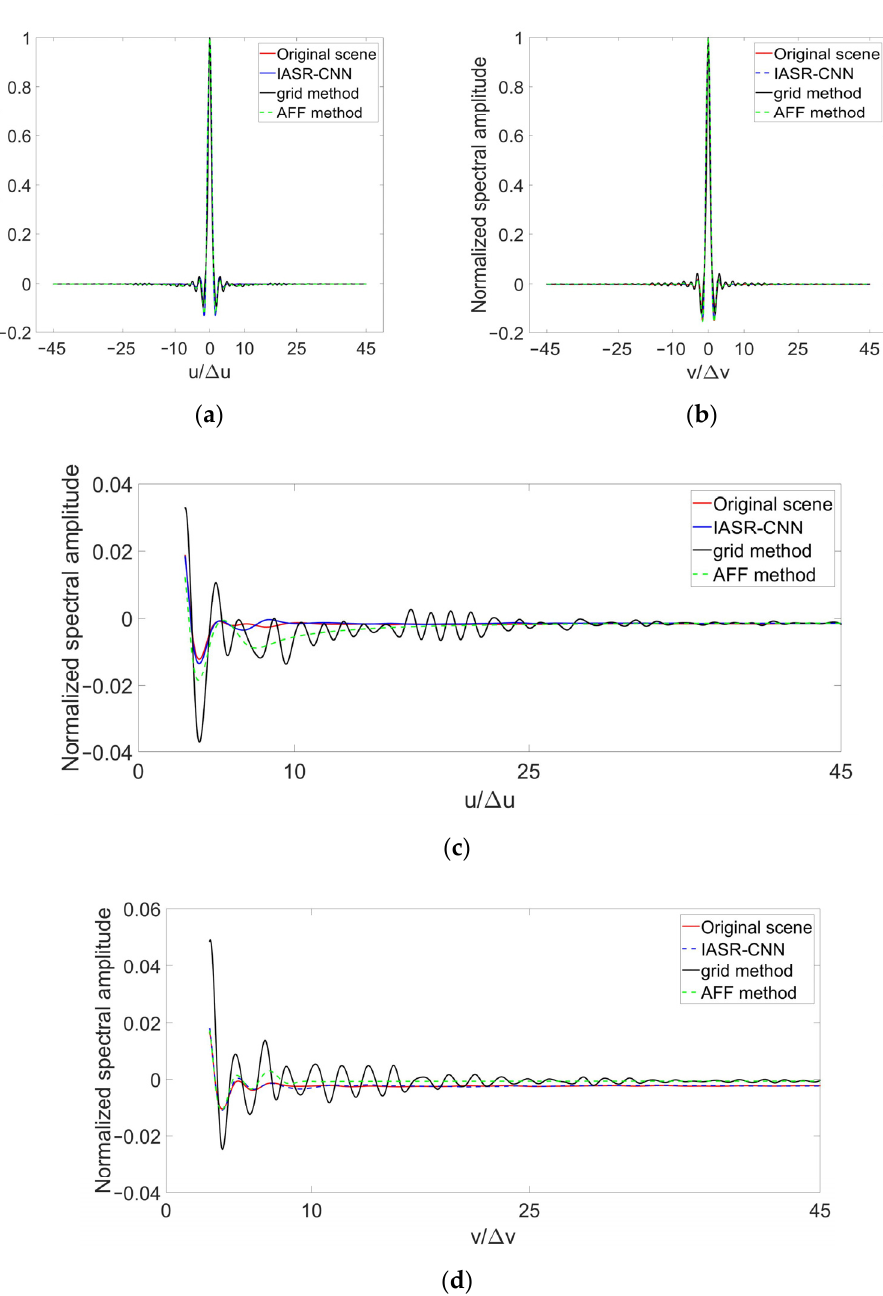
Figure 6. The spectrum of images reconstructed by different methods at the same scene. ( a ) Spec- trum in direction u . ( b ) Spectrum in direction v . ( c ) High-frequency spectrum in direction u . ( d ) High-frequency spectrum in direction v .